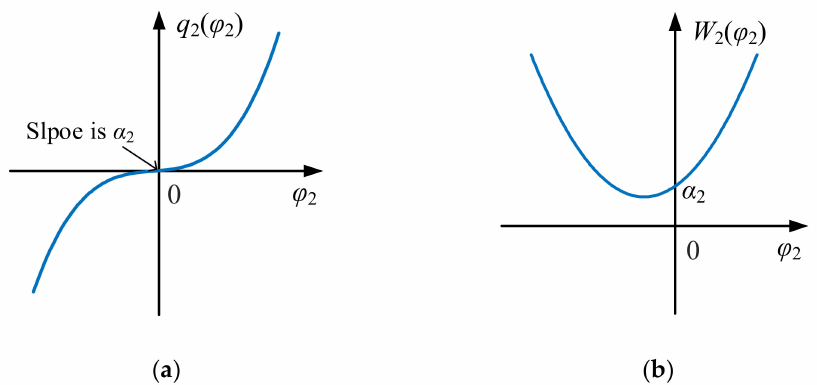
Figure 6. Characteristic curves of the piecewise-quadratic flux-controlled memristor. ( a ) ϕ 1 - q 1 ( ϕ ); ( b ) ϕ 1 - W 1 ( ϕ ).